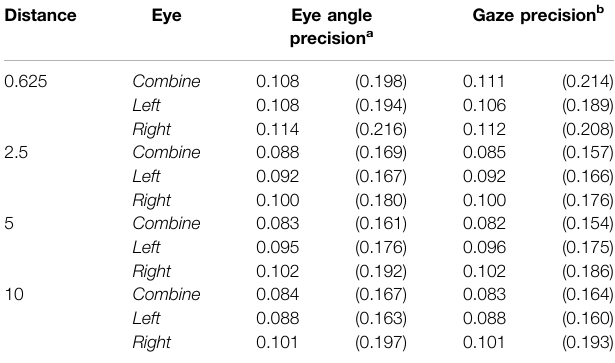
TABLE 3 | Eye and gaze precision values.